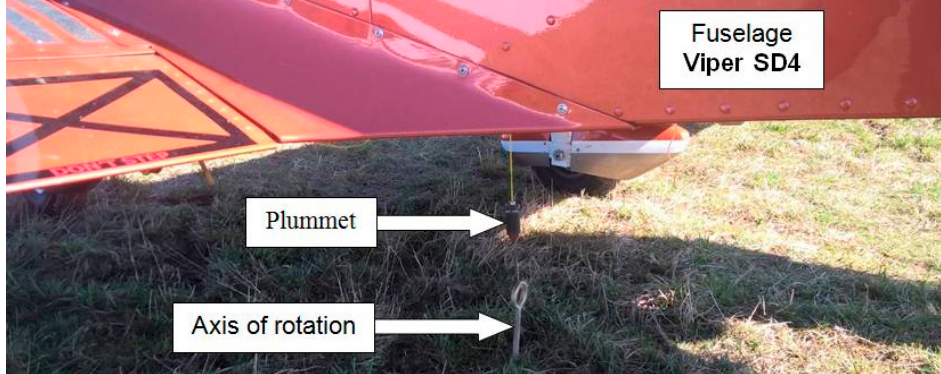
Figure 8. Method of monitoring the axial unambiguity of the aircraft position. The third series of measurements at the high position of the measuring antenna also took place in the range of 360° in 15° steps. The measurement was performed at the uppermost position of the receiving (measuring) antenna, placed on a measuring stand at a height of 5 m. The location of the measured antenna of the ELT system in the cabin of the aircraft was at the same height above the ground, i.e., 0.9 m. The height difference between the measured and measuring antenna was about 4.1 m. However, their half distance of 7.5 m represents a large positional angle of measuring the antenna ( θ = 30°) of the ELT system in the vertical plane (Figure 9).